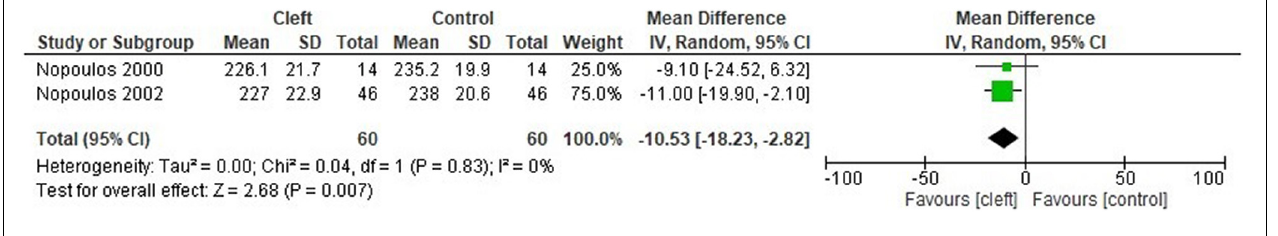
FIGURE 6 | Forest plot for temporal lobe volume (cm 3 ).